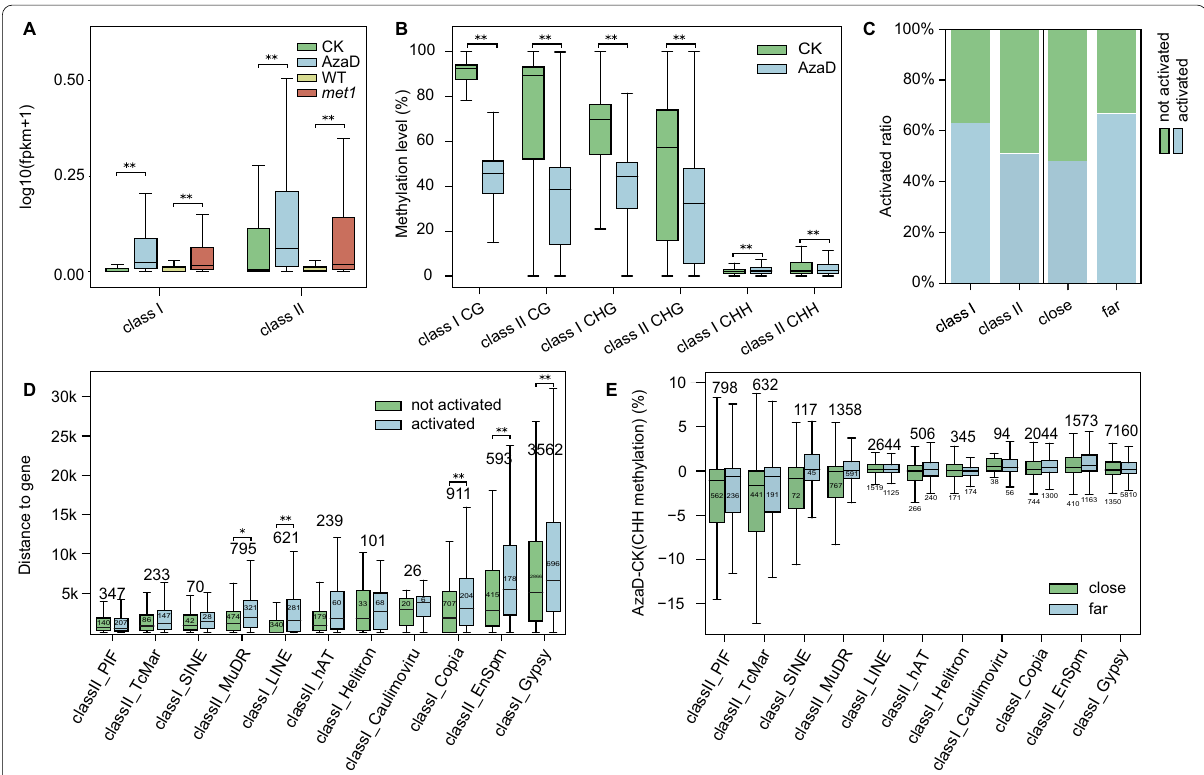
Fig. 3 TEs were significantly activated according to distance from genes. a TE expression levels in AzaD treated and osmet1-2 mutant rice. Class I retrotransposons and class II DNA transposons were significantly up-regulated in AzaD treated and osmet1-2 mutant rice. b CG, CHG, and CHH methylation levels of class I retrotransposons and class II DNA transposons in CK and AzaD treated rice. c Activated ratio of class I and class II TEs (left), close (distance to the nearest gene less than 2 kb) and far (distance to the nearest gene more than 2 kb) TEs (right). TEs with log2FoldChange(FPKM 1) > 2 were defined as activated TEs. Class I and far TEs had higher activation ratios. d Distances of activated and not + activated TEs from different TE families to the nearest genes. TE families were ordered according to the average distance to the closest gene. Activated TEs tended to be farther from genes. e CHH methylation level changes of close and far TEs from different families. TE families were ordered according to the average distance to closest gene. TEs in families farther from genes showed increased CHH methylation levels. * p < 0.05, ** p <